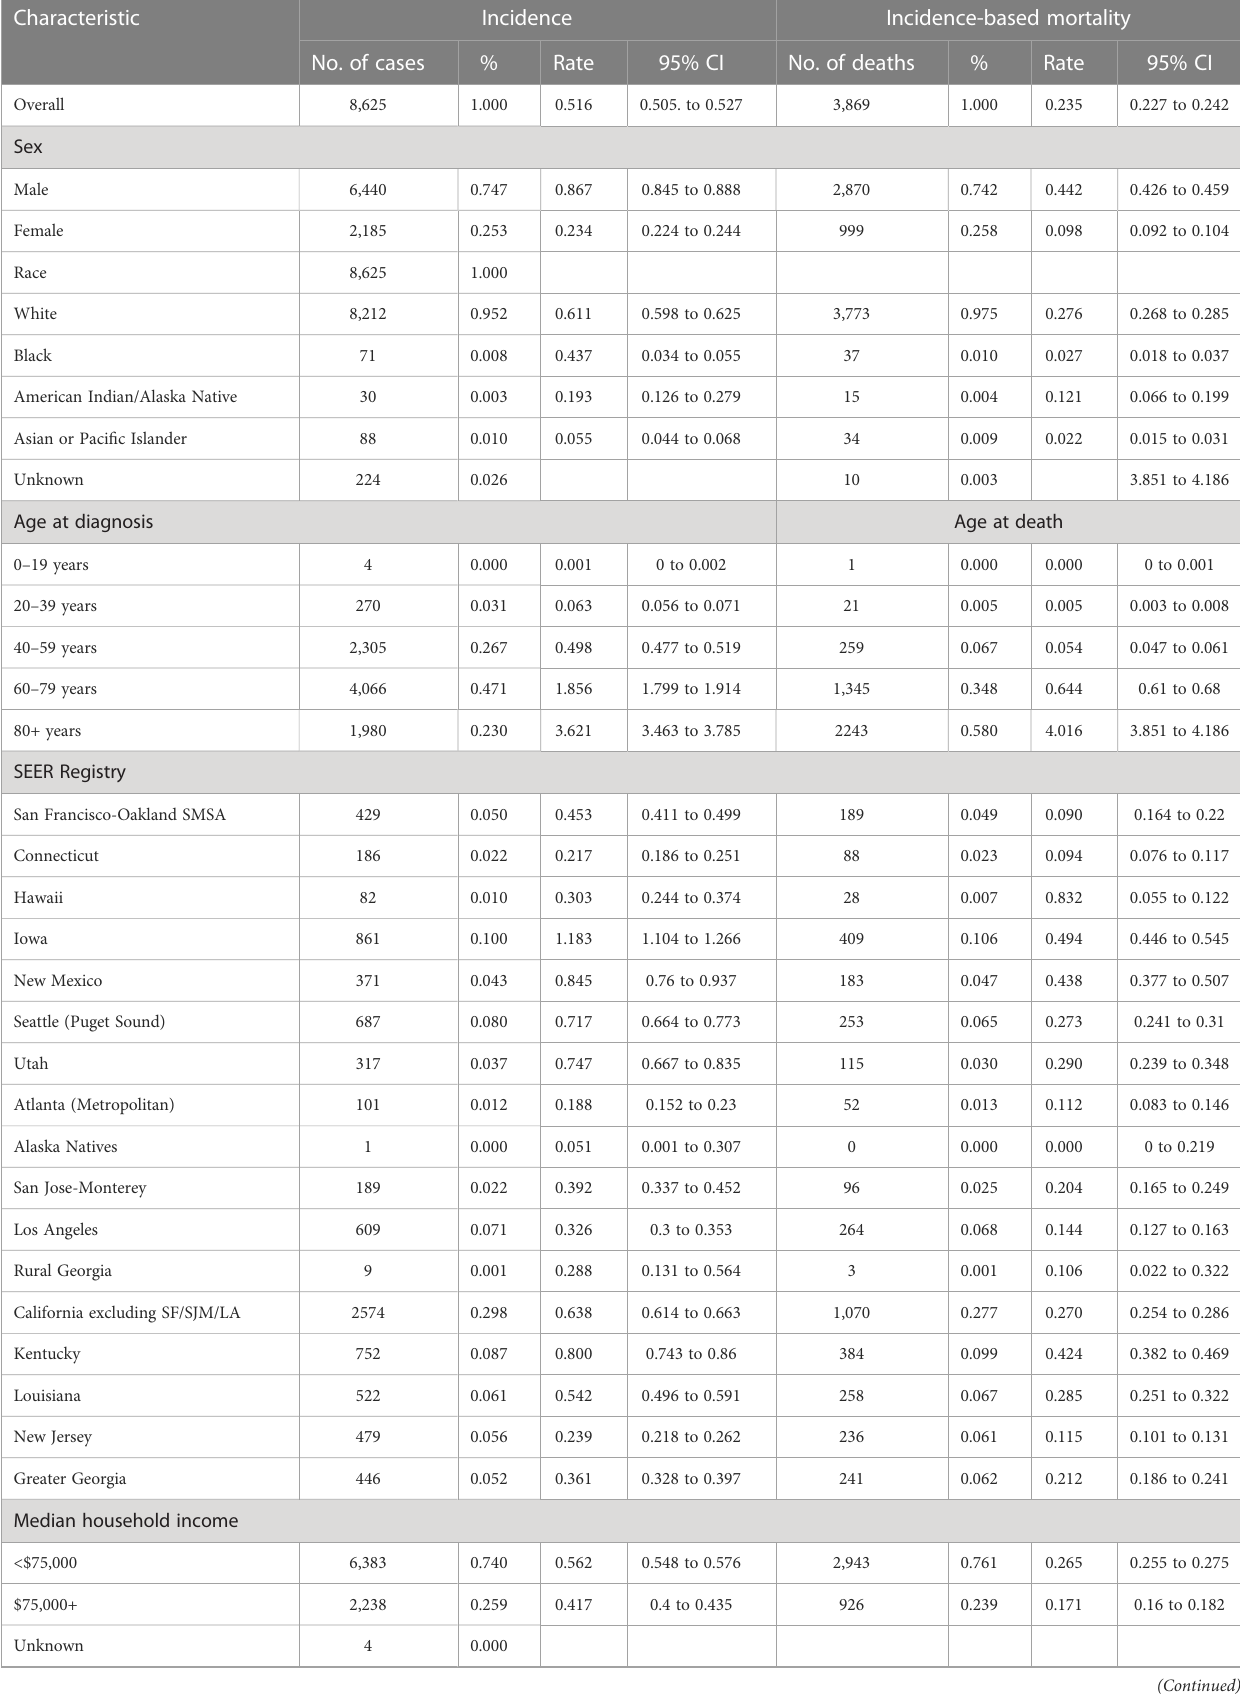
TABLE 1 cSCC on the lip incidence and incidence-based mortality (2000 – 2019): The SEER-17 registry database.